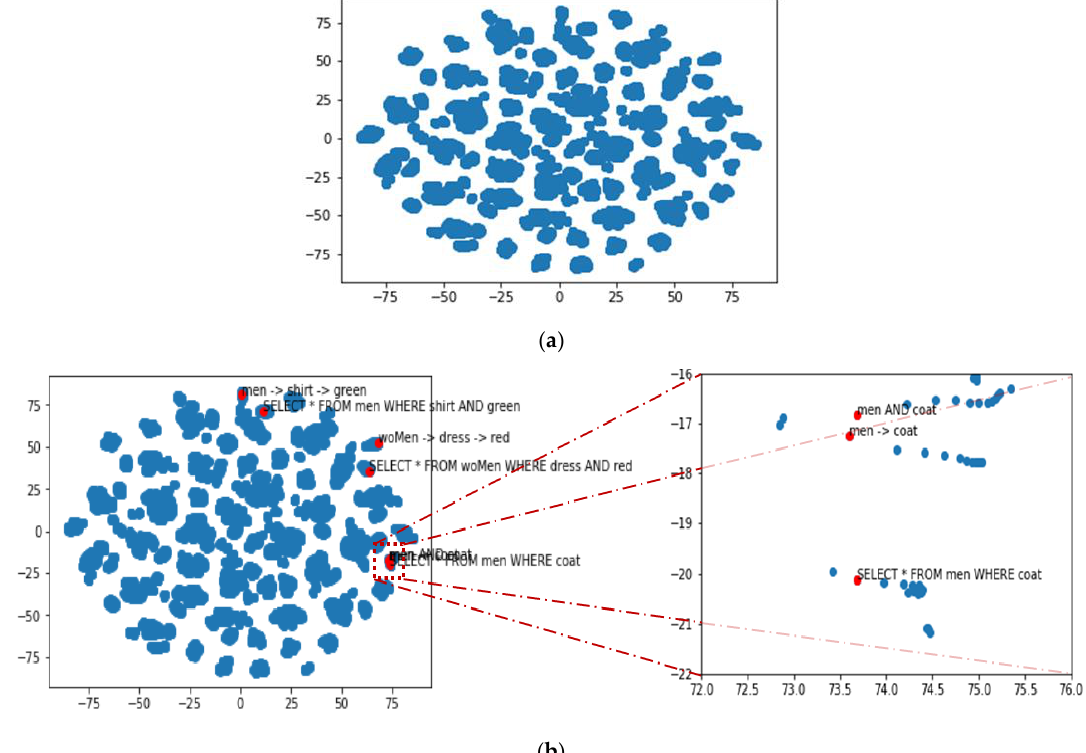
Figure 4. Visualization of the results of the pre-training using t-SNE: ( a ) query distribution, ( b ) neighbor embedding.